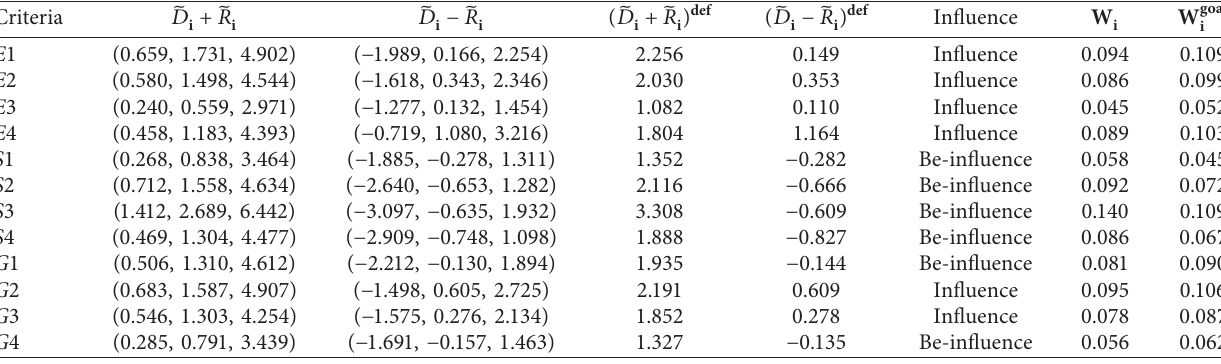
Table 21: Importance weight of sustainability criteria in Z-number condition.